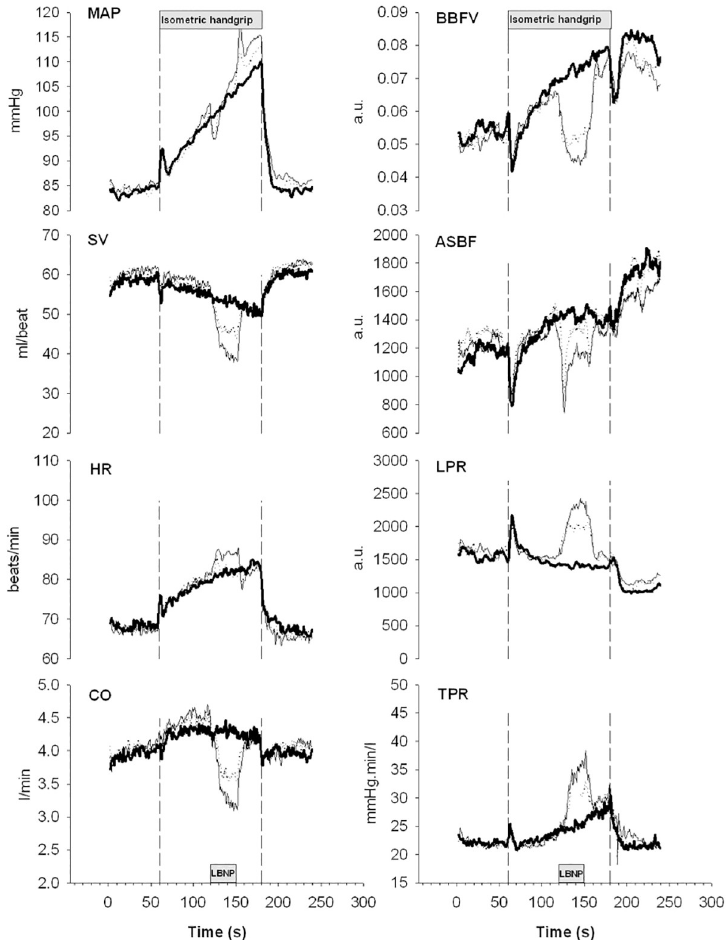
Fig 3. Pooled average trends of the individual cardiovascular responses (n = 11) to 2 min isometric handgrip contraction (40% of maximal voluntary contraction). Bold lines show mean arterial pressure (MAP), stroke volume (SV), heart rate (HR), cardiac output (CO), blood flow velocity in the brachial artery (BBFV), acral skin blood flow perfusion (ASBF), local peripheral resistance (LPR) and total peripheral resistance (TPR) during isometric handgrip in supine position (P1). Dotted lines and hairlines show the responses during a transient reduction in preload induced by onset of lower body negative pressure during the ongoing contraction. Dotted lines show the responses to application of mild LBNP (-20mmHg, P2) and hairline the response to moderate LBNP (-40mmHg,